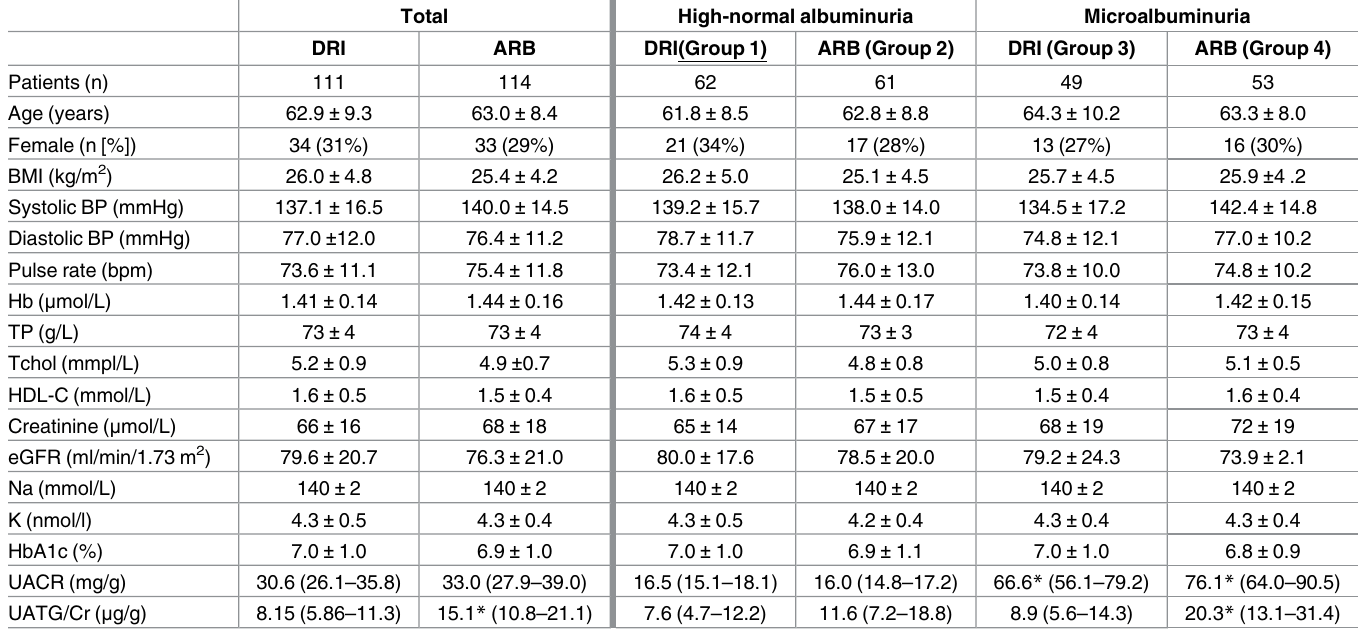
Table 2. Baseline